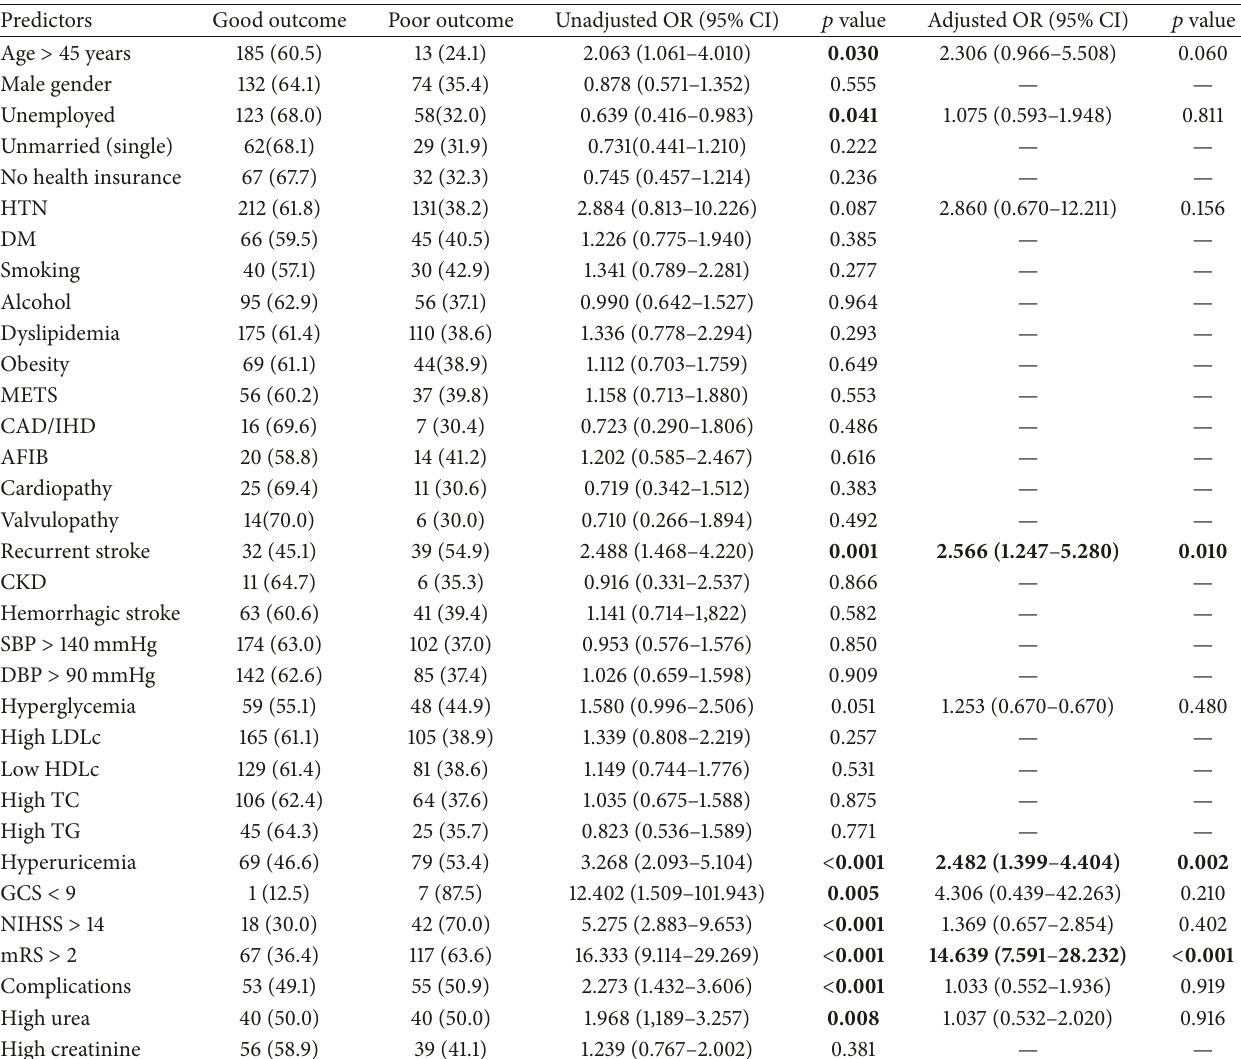
Table 4: Independent predictors of poor functional outcome within 3 months post